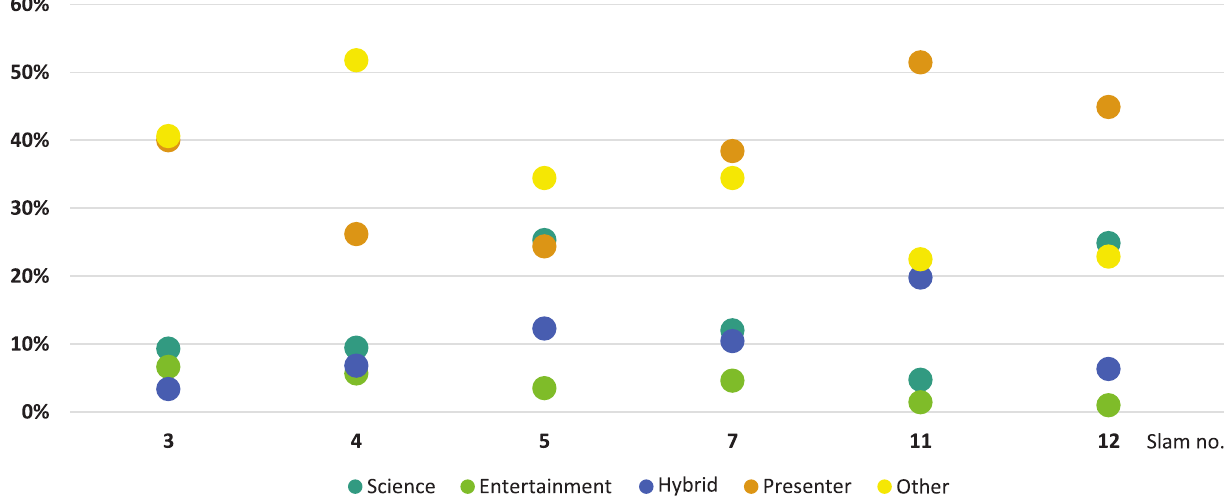
Figure 6. Viewing rate (gaze time on visible elements as percentage of total reception time) for the three AOI categories, the presenter and “other” unclassified elements in the scenery in six science slam presentations. Note: The numbering of the slams corresponds to that in Figure 2, the presentation by Reinhard Remfort is slam no.